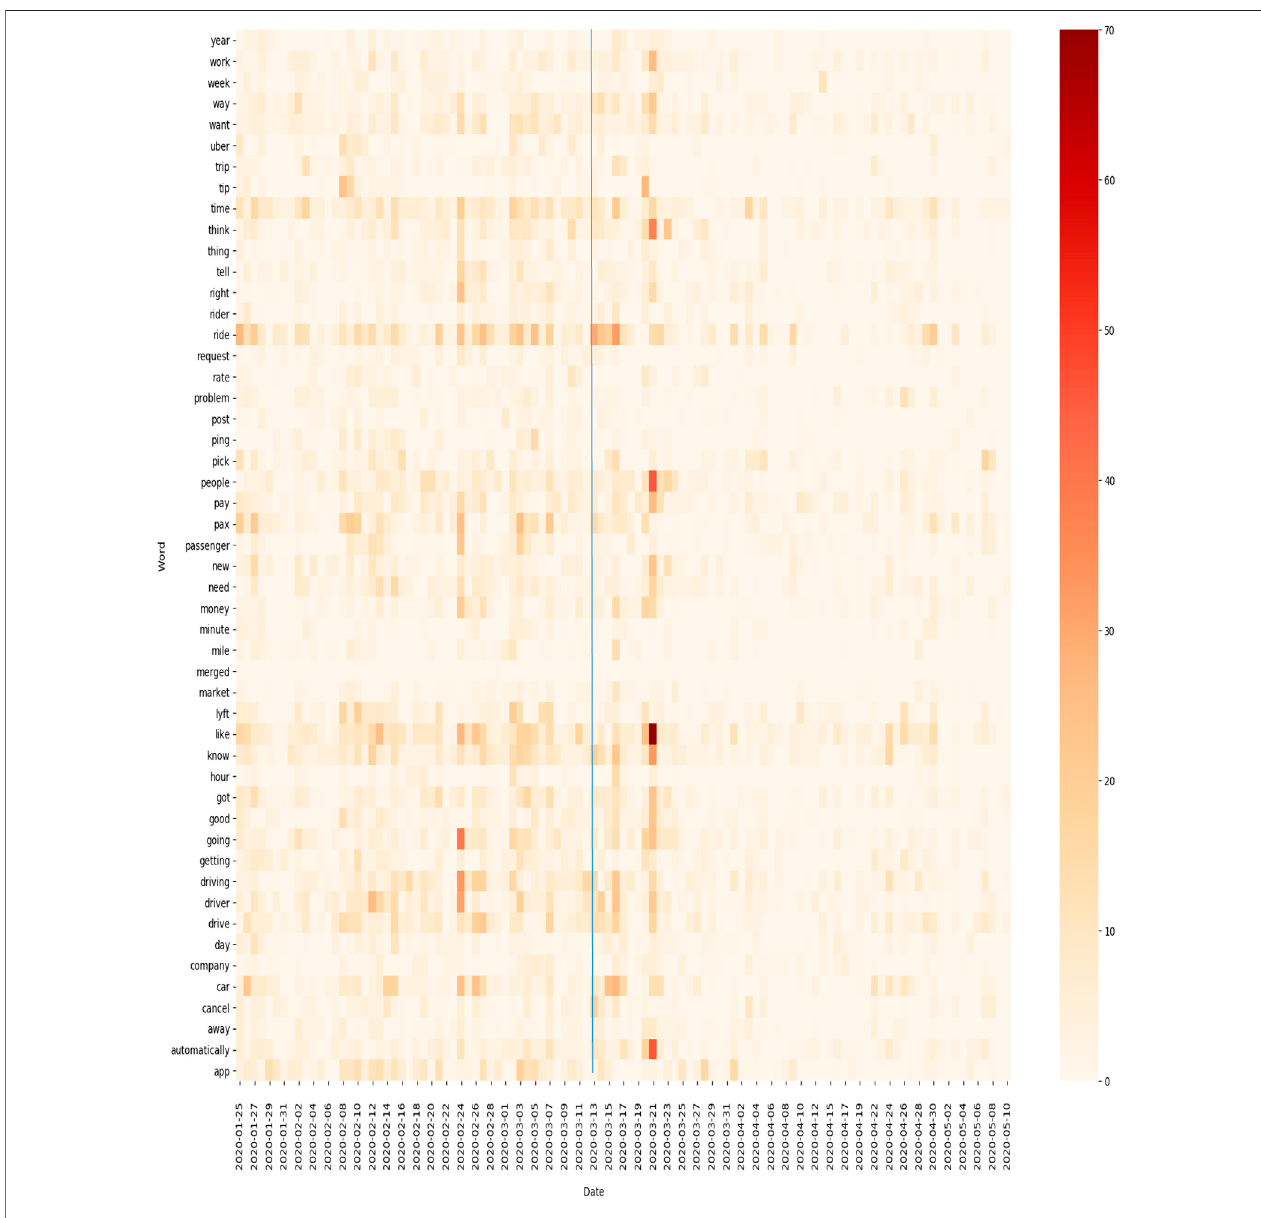
FIGURE 2 | Heatmap of Lyft